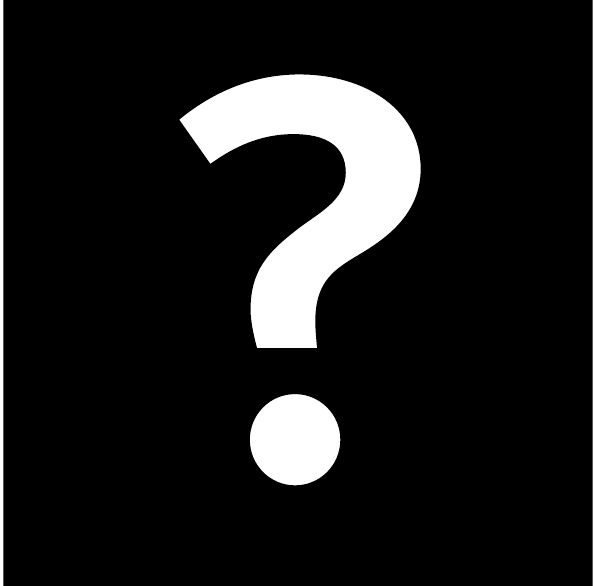
Fig. 8 Is there any missing figure in this manuscript?: “Take the use of the message board as an example, select [Message Board] on the right side of Figure 8, enter the message display page, click the [All Messages]”